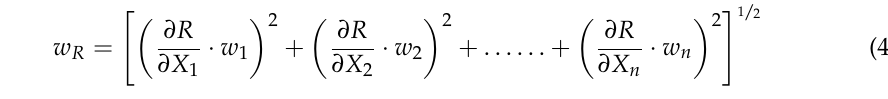
Table 5. The uncertainty in the measurements and the calculations. Instrument Range Accuracy Uncertainty (%)